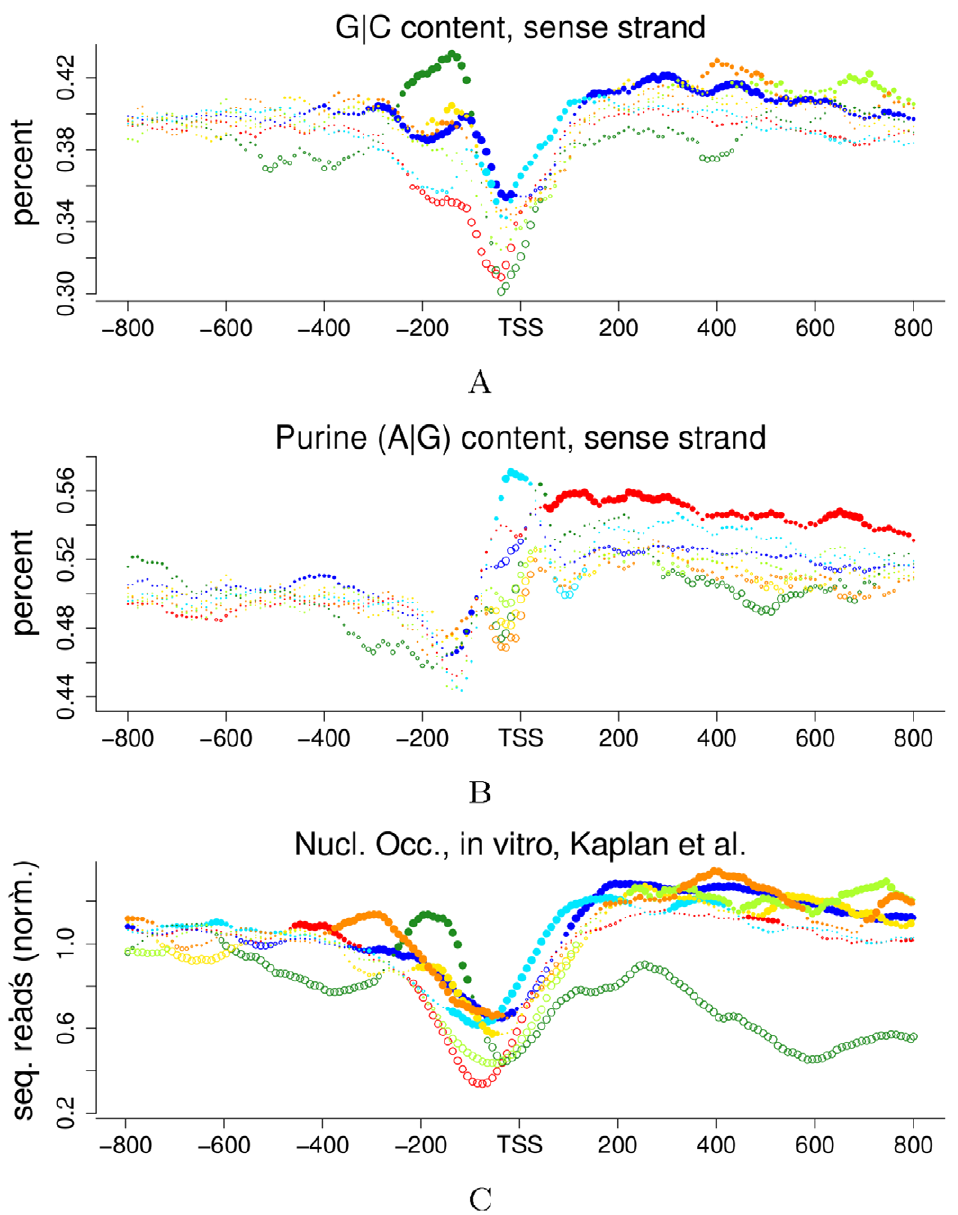
Figure 7. Summary of results & proposed feedback model. 7A: temporal flow of expression and functional relationships of cluster transcripts in the 0.7 h system (left to right) and the 5 h system (top to bottom). 7B: summary of observed properties (significant enrichment or biases) of the main gene clusters. 7C: Potential regulatory interactions of broad cellular functionality via the energetic status of the cell, reflected, e .g., in ATP:ADP ratios. In the oxidative phase catabolic activity leads to a high ATP synthesis rate. At high ATP:ADP ratios promoters of anabolic genes are active, potentially mediated by ATP-dependent nucleosome remodeling, which at the same time keeps promoters of catabolic genes in a repressed state. When respiratory activity suddenly slows down in the reductive phase the activity of the anabolic genes, i .e., amino acid and protein synthesis, leads to a decrease of the ATP:ADP ratio and the promoters of catabolic genes become active. Diverse cellular stresses may result in a sudden drop in the cellular ATP:ADP ratio due to the energetic costs of immediate biochemical stress response.